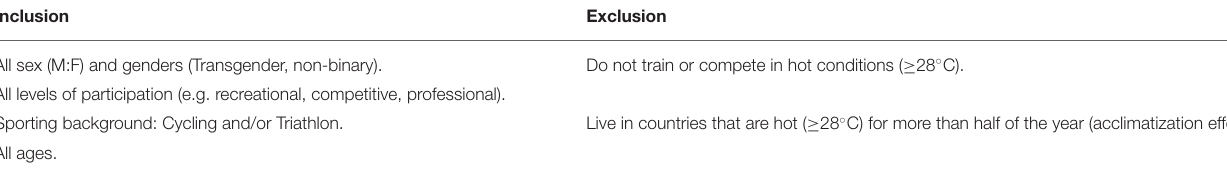
TABLE 1 | Table outlines inclusion and exclusion criteria for participants. Inclusion Exclusion All sex (M:F) and genders (Transgender, non-binary). Do not train or compete in hot conditions ( ≥ 28 ◦ C). All levels of participation (e.g. recreational, competitive, professional). Sporting background: Cycling and/or Triathlon.